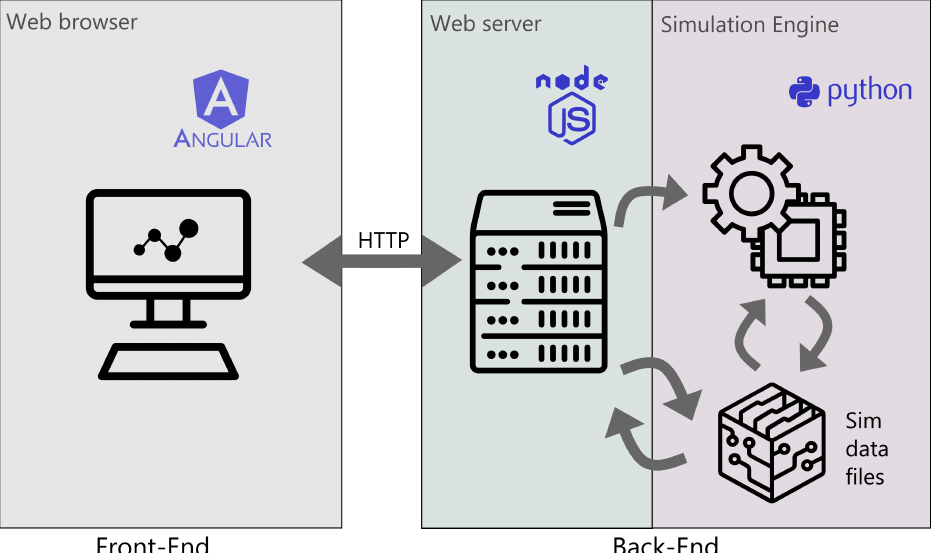
Figure 2. Web-based environment